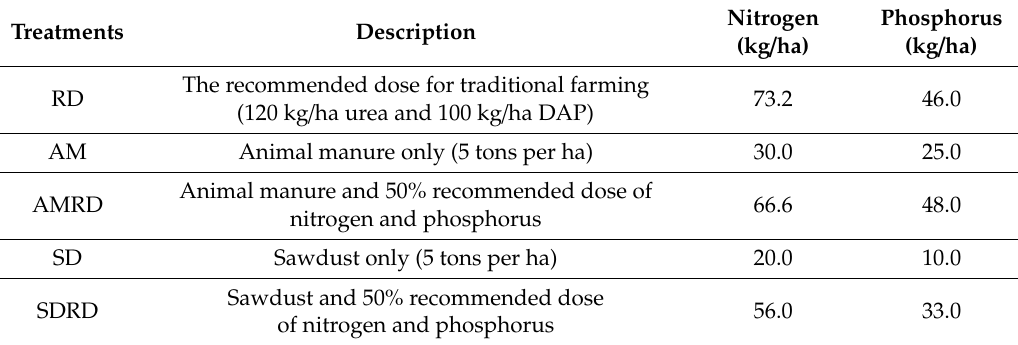
Table 1. Amount of nitrogen and phosphorus in treatments from di ff erent fertilizers.